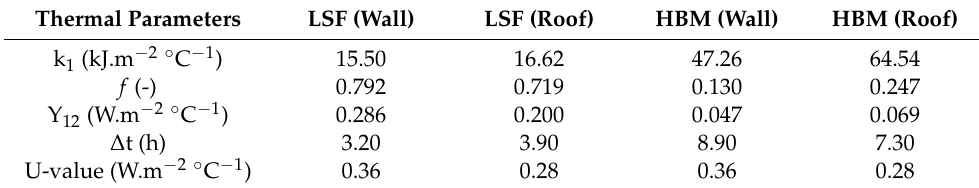
Table 1. Thermal parameters of the external opaque envelope